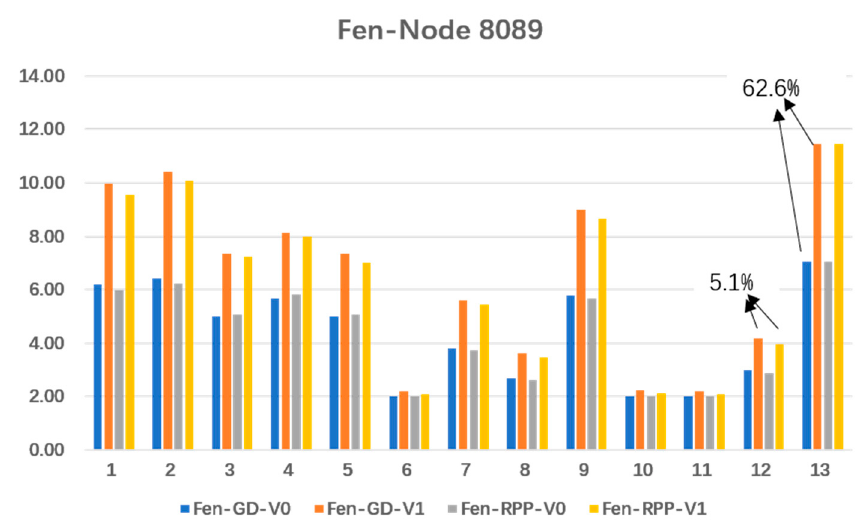
Figure 5. F en values of Node 8089 with each transient combination. Table 7. The cumulate fatigue usage factor in air and water environments using different strain rate approaches and F en expressions of RPV inlet nozzle.